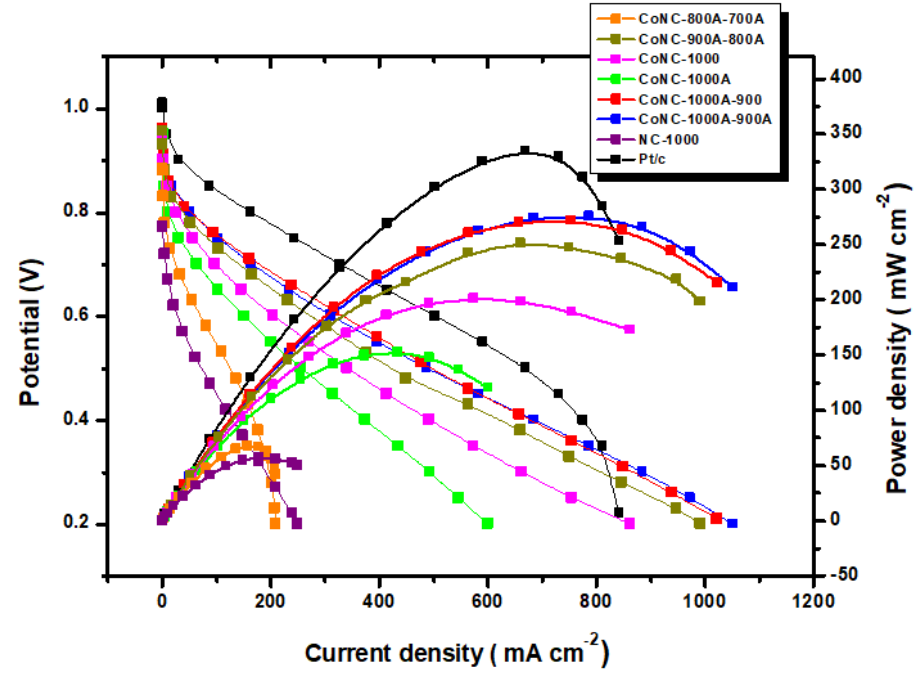
Figure 10. Power density and potential vs. current density of various single cells.